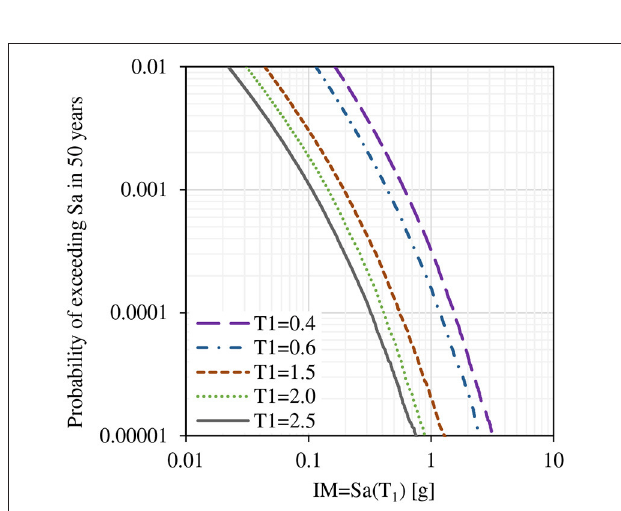
FIGURE 9 | Ground motion hazard curve for Vancouver for different periods on soil Class C.